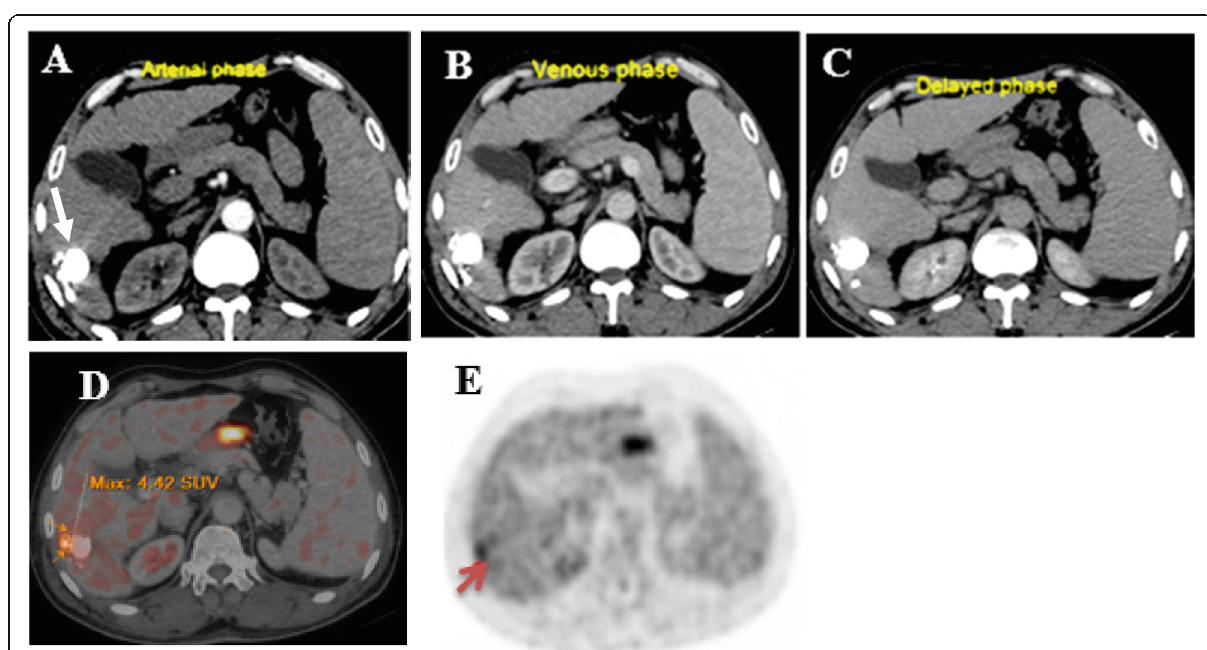
Fig. 3 a – c CECT phases showing lipiodol concentration at chemoembolized lesion at the right lobe (segment VI) with no residual enhancement detected(arrow). d Fused PET/CT image showing increased FDG uptake at the periphery of the embolized lesion at segment VI (masked by lipidol at CT images). e Axial CTAC image showing the focal FDG uptake around the embolized lesion (red